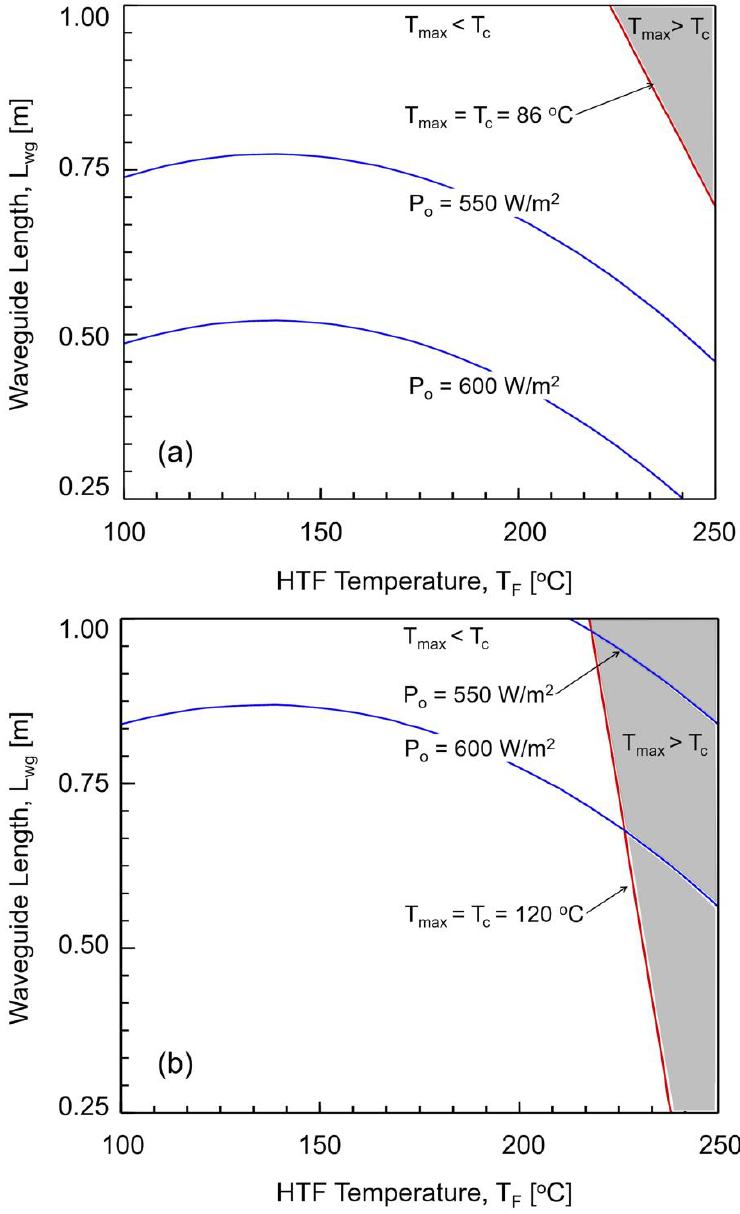
Figure 8. Design envelopes for permissible waveguide length based on the maximum operating temperature and minimum power density considerations for: ( a ) ZK7 and ( b ) PC waveguide. The receiver radius is 0.01 m, waveguide thickness is 0.025 m, and incident irradiation is 1000 W/m 2 .